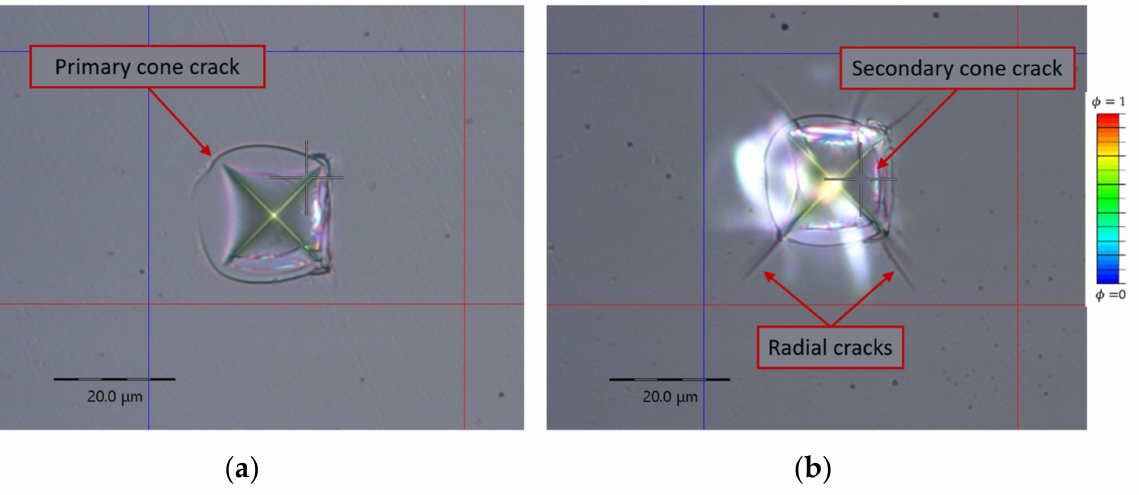
Figure 2. Residual indents and different fracture patterns after Vickers indentation on fused silica glass, ( a ) indent showing only primary cone crack, ( b ) indent with secondary cone crack and radial cracks at the edge of the